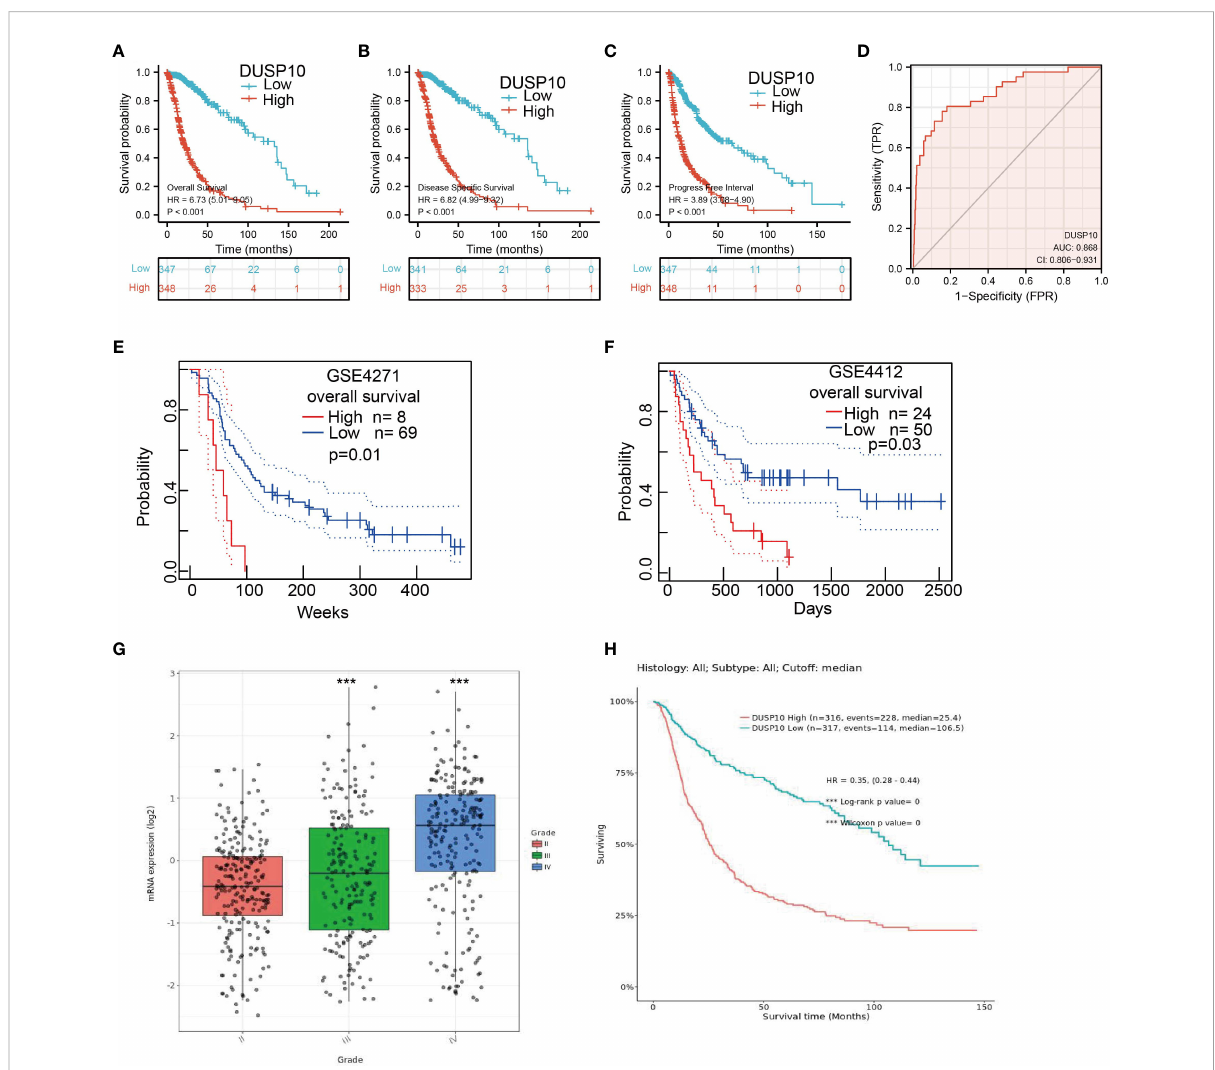
FIGURE 3 Kaplan – Meier survival analysis, and ROC curve of DUSP10 in glioma. (A – C) Kaplan – Meier survival analysis correlated high expression of DUSP10 with the poor prognosis of OS, DFS, and PFS for glioma patients using TCGA databases. (D) ROC curve analysis to evaluate the prognostic value of DUSP10 expression in glioma examined by TCGA database. (E, F) Kaplan – Meier survival analysis correlated high expression of DUSP10 with the poor prognosis of OS for glioma patients using the GEO database. (G, H) CGGA database was used to validate the grade and prognosis of DUSP10 in glioma. *** p < 0.001. ROC, receiver operating characteristic; OS, overall survival; DFS, disease-speci fi c survival; PFS, progression- free survival; GEO, Gene Expression Omnibus; CGGA, Chinese Glioma Genome